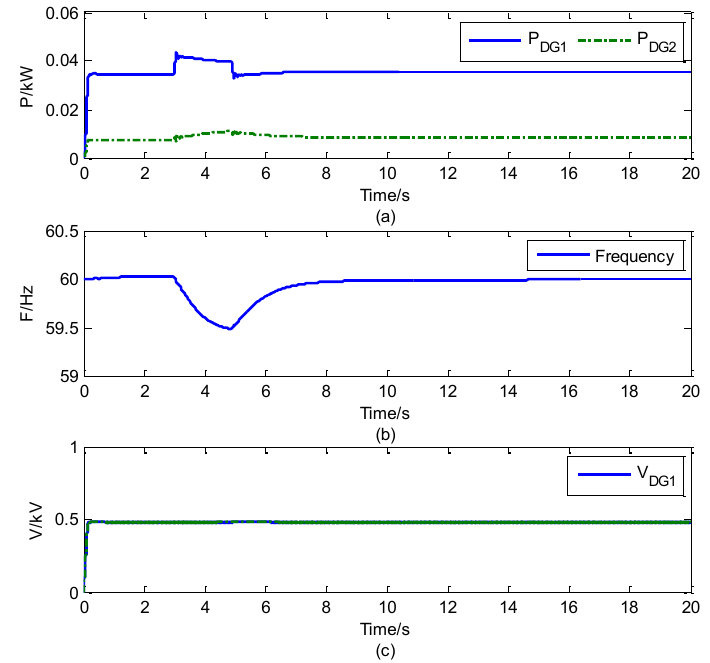
Figure 4. The performances of the proposed distributed load shedding of Case A. ( a ) The power outputs of DGs; ( b ) the frequency response of the islanded microgrid; ( c ) the voltage responses of DGs; ( d ) the capacity of the flexible loads and the amounts of loads to be